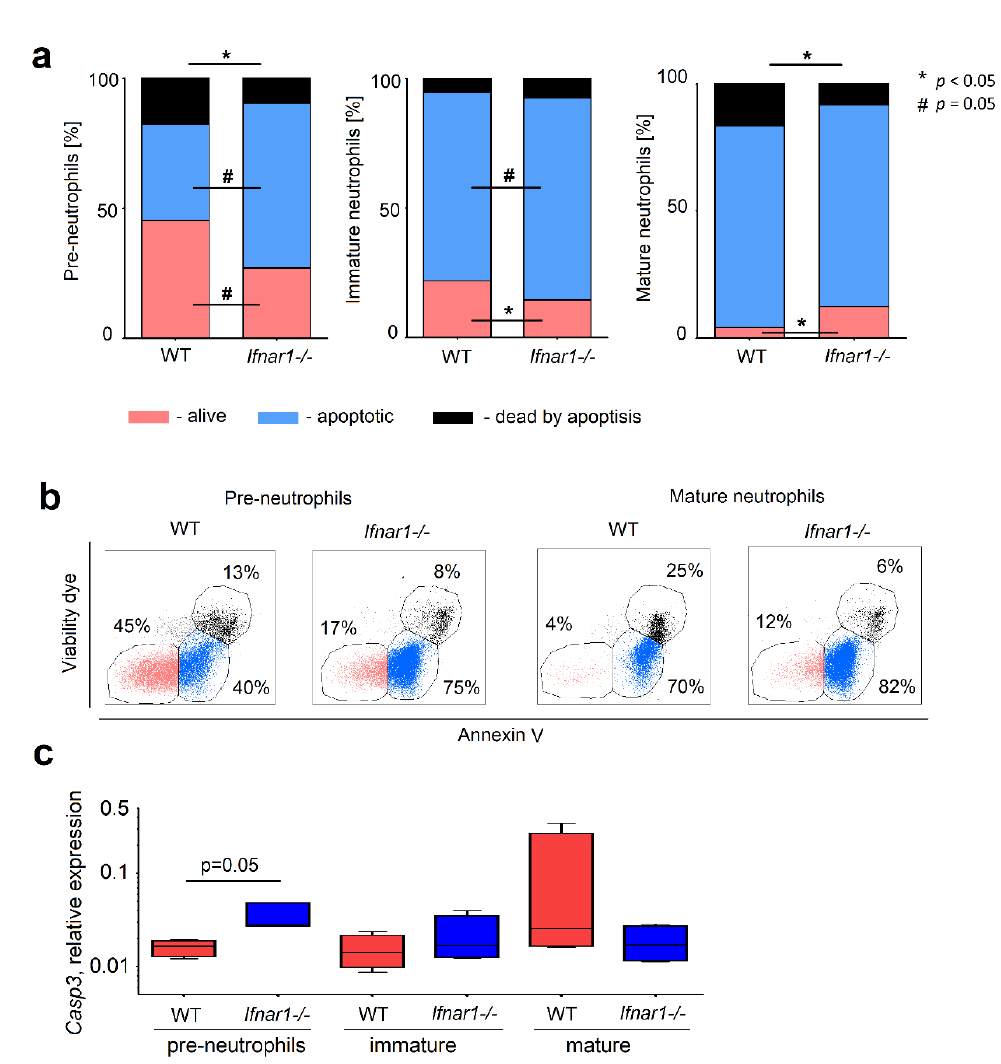
Figure 3. IFN-deficiency is associated with decreased survival of early progenitors, but increased survival of mature neutrophils in bone marrow. ( a ) Percentage of alive (annexin V – / 7-aminoactinomycin (7-AAD – )), apoptotic (early apoptosis, annexin V + / 7-AAD – ), and dead by apoptosis (late apoptosis, annexin V + / 7-AAD + ) cells from all single cells in late stages of neutrophils maturation. Pre-neutrophils, immature and mature neutrophils from bone marrow of naive WT and Ifnar1 - / - mice were isolated after 18 h of staining with annexin V and viability dye 7-AAD; ( b ) Gating strategy of alive, apoptotic, and dead by apoptosis cells and examples of populations for pre- and mature sorted neutrophils of WT and Ifnar1 - / - mice; ( c ) Relative expression of Casp3 gene in pre-, immature and mature neutrophils. n = 4 mice per group. Data are presented as median, 25th and 75th percentiles, and minimal and maximal values. * p <